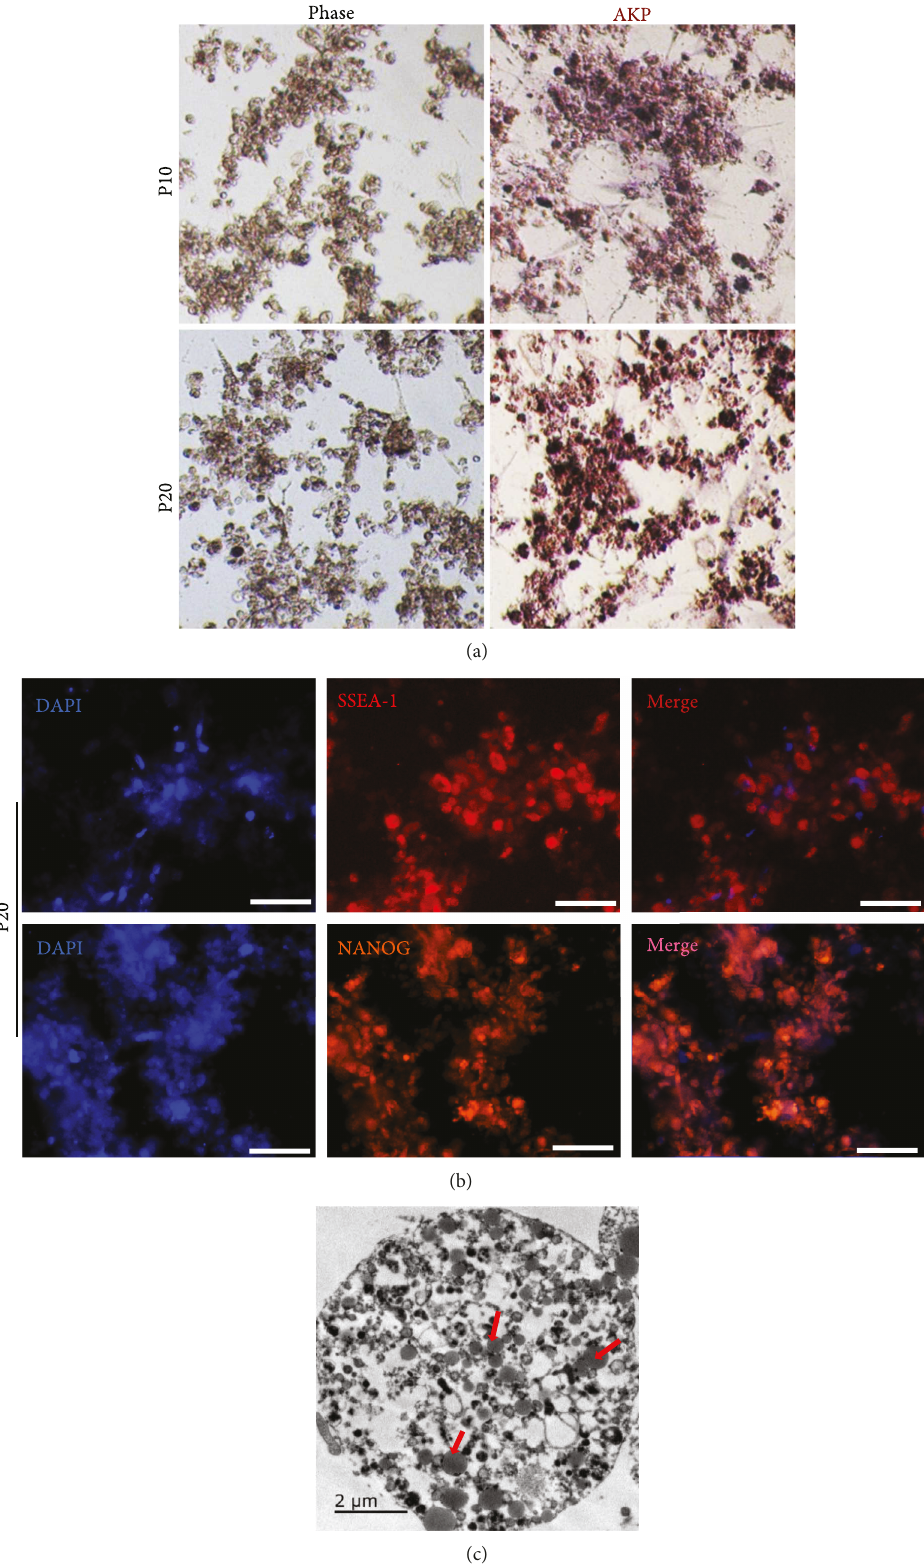
Figure 3: Identi fi cation of cESCs in vitro . (a) cESCs in the complete culture system showed alkaline phosphatase activity over 20 passages. (b) Pluripotency marker pro fi le of cultured cESCs after 20 passages. Scale bar: 100 μ m. (c) The transmission electron microscopy (TEM) photos of cESCs and red arrows indicated the lipid droplets. Scale bar: 2 μ